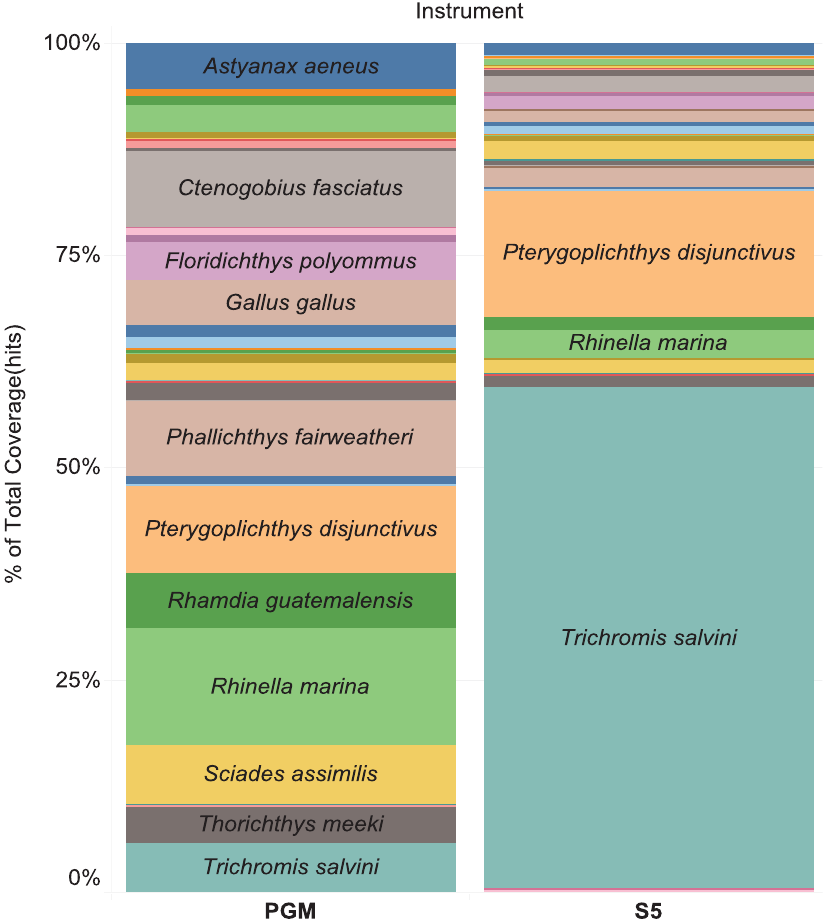
Fig 6. Percentage of total read coverage for each species recovered in water samples from April 2016 and mock experiment, analyzed with Ion Torrent PGM and S5 instruments.